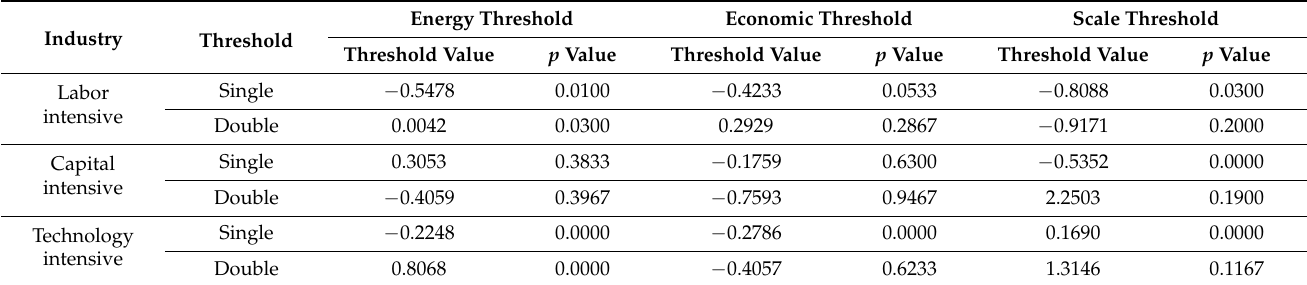
Table 7. Threshold effect test